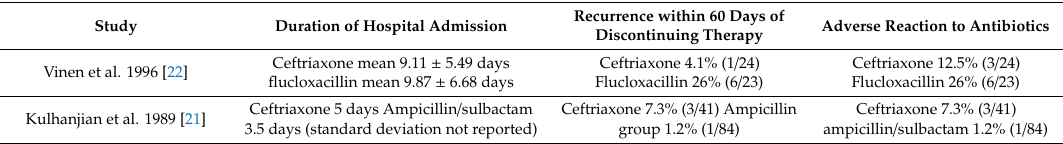
Table 4. Outcomes (randomised